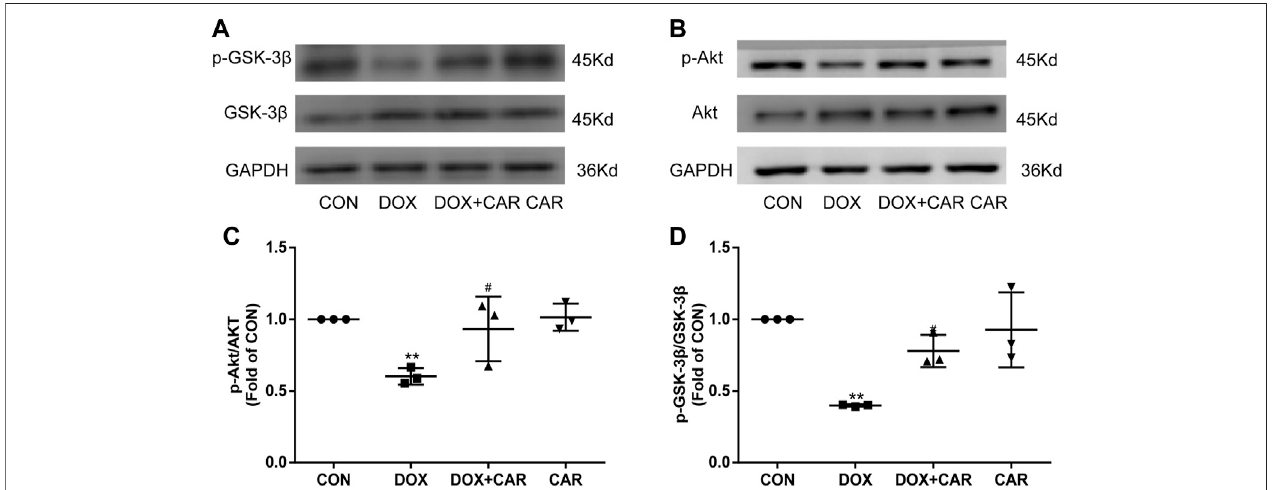
FIGURE 6 | Effect of CAR on Akt/GSK-3 β signaling following DOX-induced cardiotoxicity. (A) : Representative western blots of GSK-3 β , (B) : Representative western blots of Akt, (C) : Histogram representing the quantitative analysis of GSK-3 β , (D) : Histogram representing the quantitative analysis of Akt. Quantitative data are means ± SEM (n = 3). ** p < 0.01 vs. CON; # p < 0.05 < 0.01 vs.